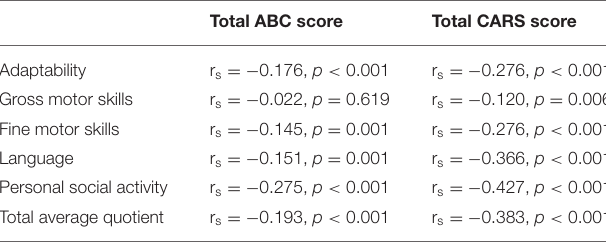
TABLE 3 | The association between developmental quotient of GDS and symptoms of autism in children with GDD.